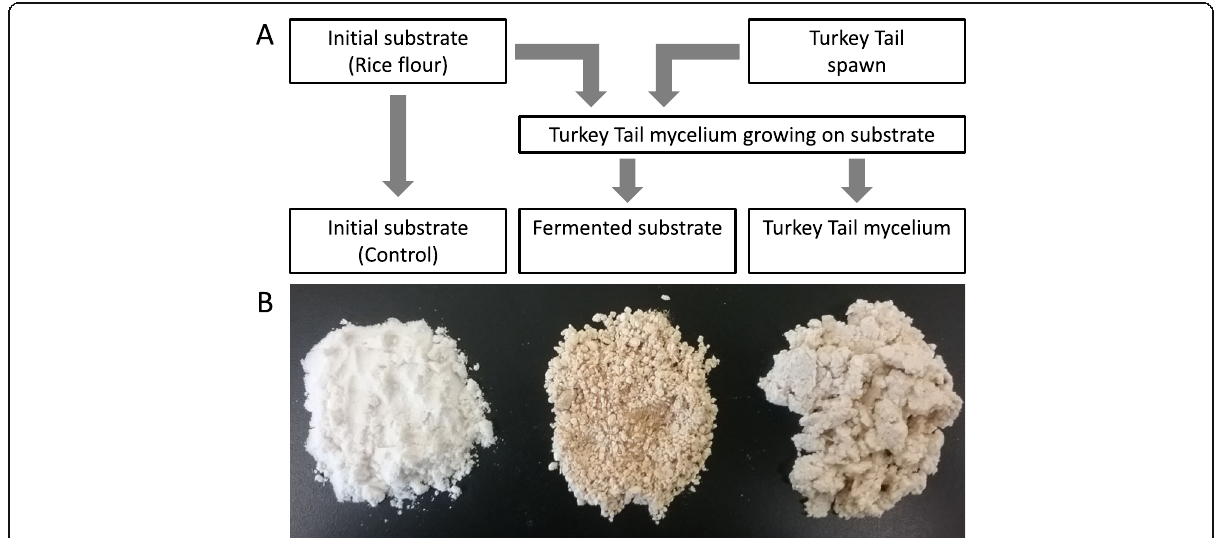
Fig. 2 Trametes versicolor (Tv) was used as an experimental model to isolate and compare the mycelium and its fermented substrate. a Diagram showing the origin of the three test products compared: Initial substrate (rice flour), fermented substrate, and Tv mycelium. b Photo of the three powders: Initial substrate (left) is plain rice flour prior to use as a substrate for growing the Tv mycelium. The fermented substrate (center) is the dried residual powder where the mycelium has been removed. The mycelium (right) is the collection of fungal hyphae, removed from the fermented substrate on which it was